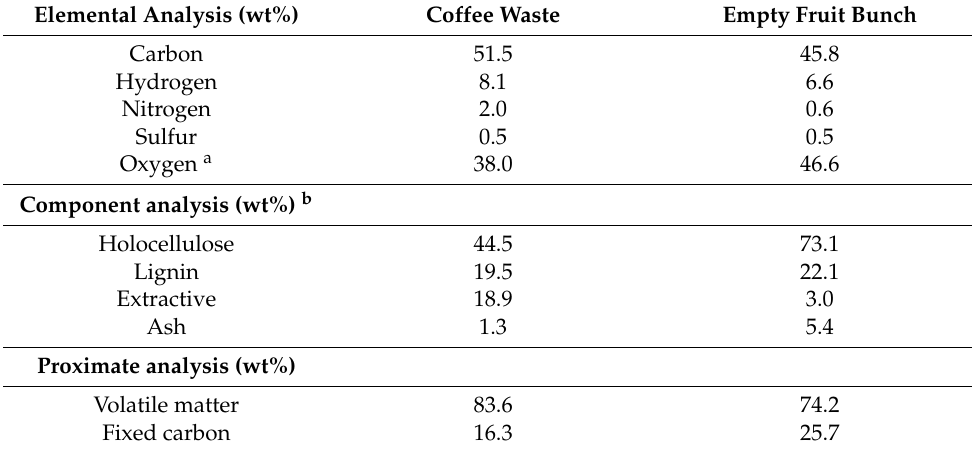
Table 1. Characterization of physicochemical properties of feedstock.